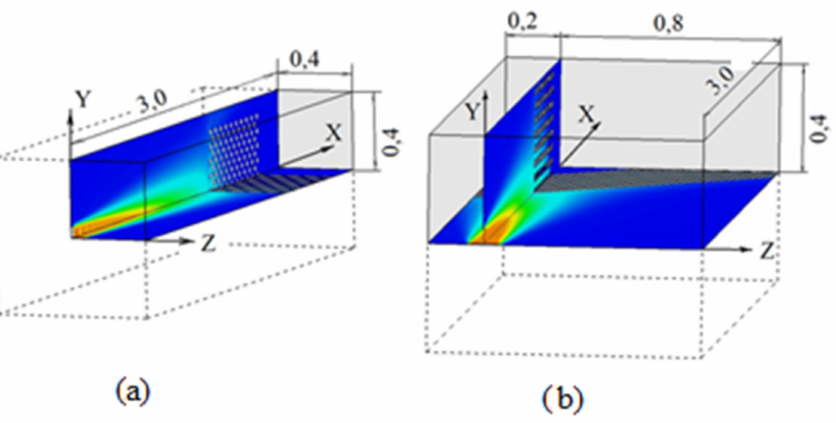
Figure 2. Computational domains. ( a ) Blowing at an angle of α = 90 ◦ ; and ( b ) blowing at an angle of α = 45 ◦ . Dimensions in